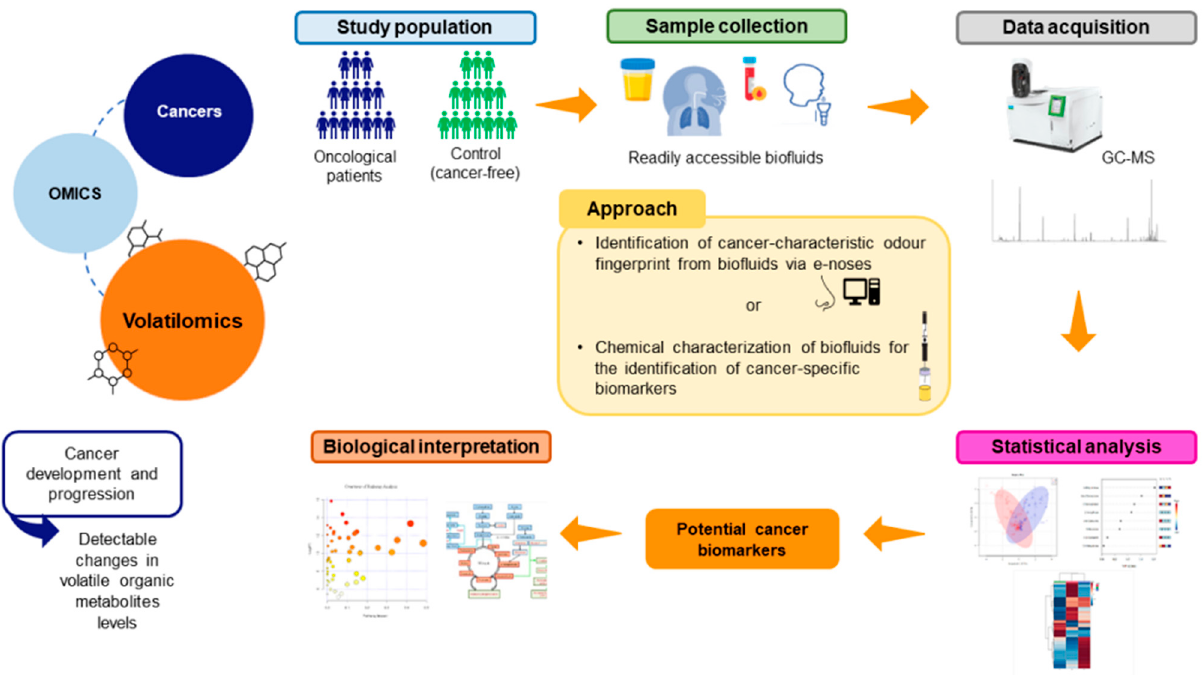
Figure 3. General flowchart of volatilomics approaches.